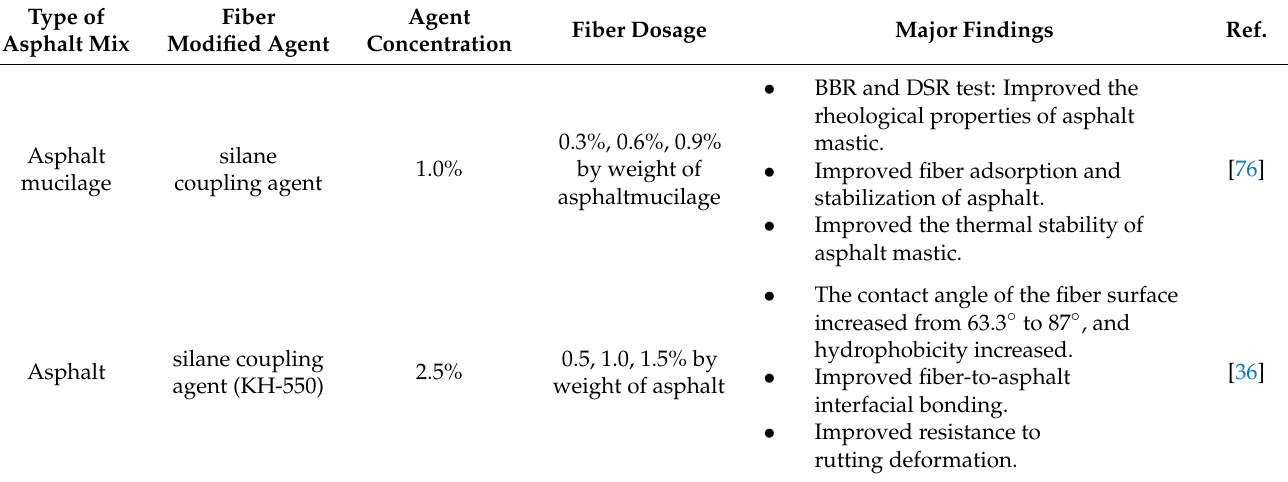
Table 4. Summary of fiber surface modifiers in basalt fiber asphalt